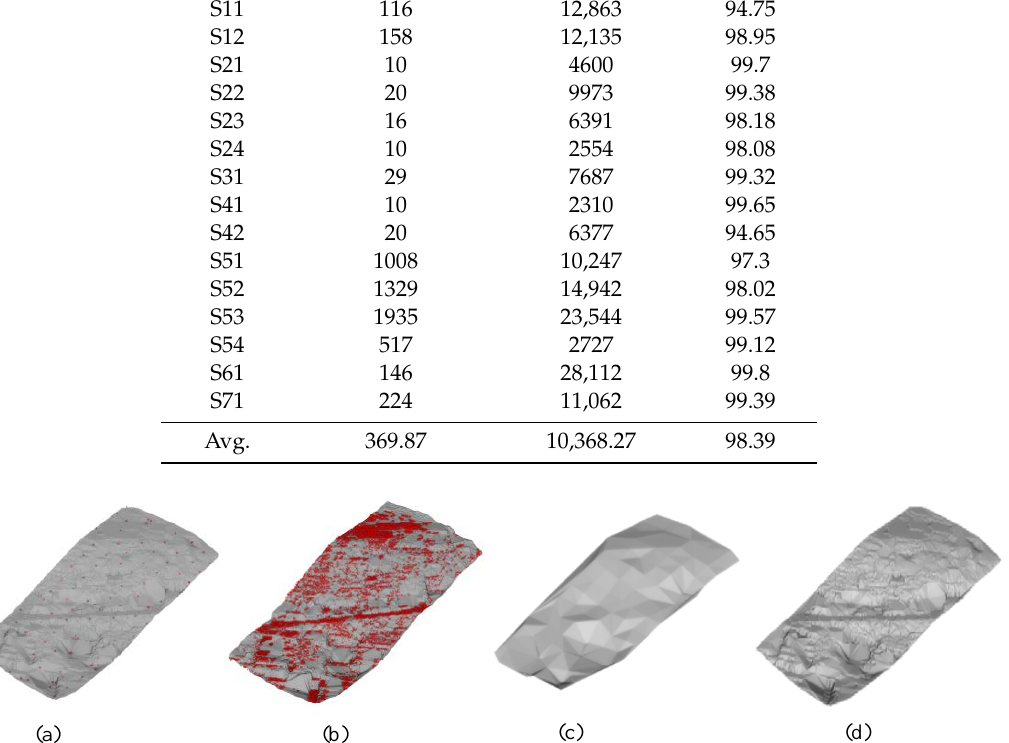
Figure 22. Cloth simulation time and total error at different CR values.